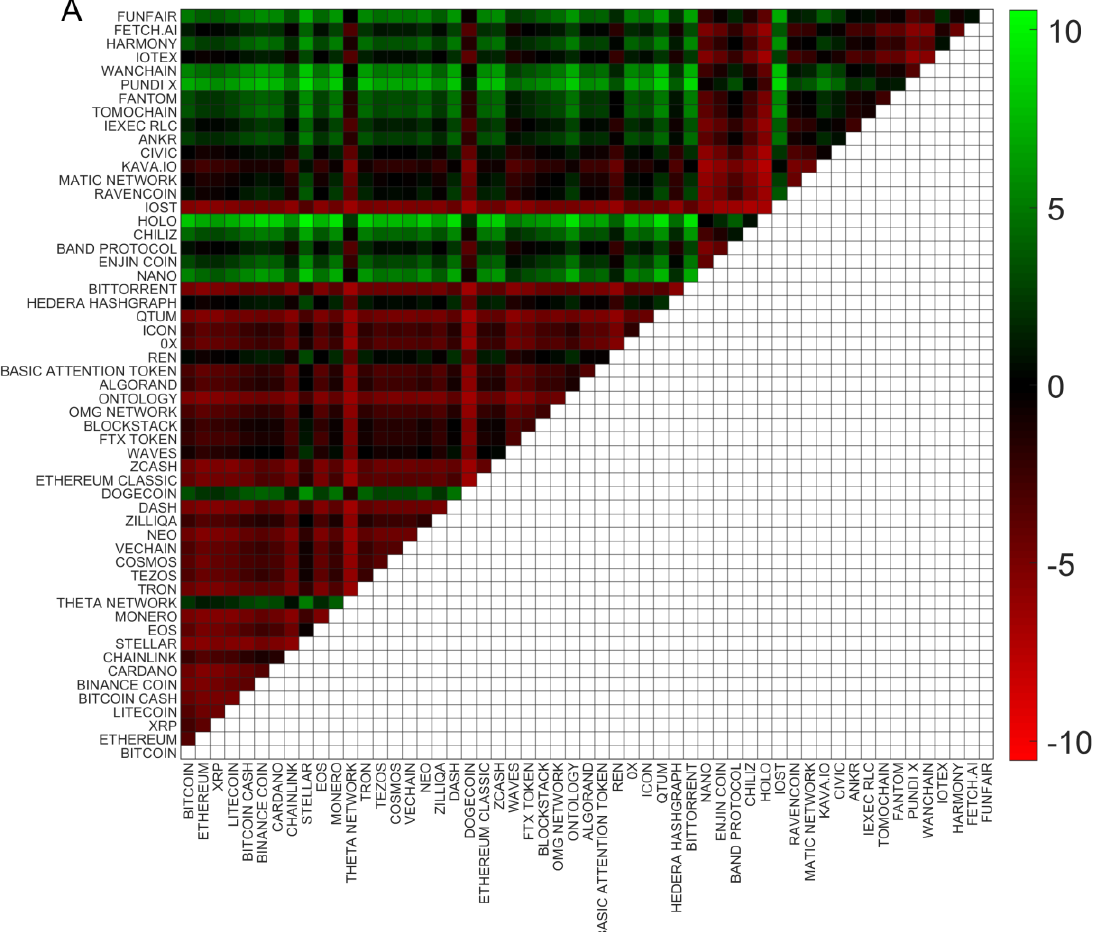
Fig. 7. Risk reduction. 7A. Synchronous trading condition. Each pixel value corresponds to the total risk reduction achieved by diversification of portfolio between the corresponding pair of cryptocurrencies for all synchronous trading frequencies (1-24 Hz). Positive values indicate net reduction of risk while negative values indicate net increase of risk as compared to a portfolio containing only the cryptocurrency with the higher market capital in the